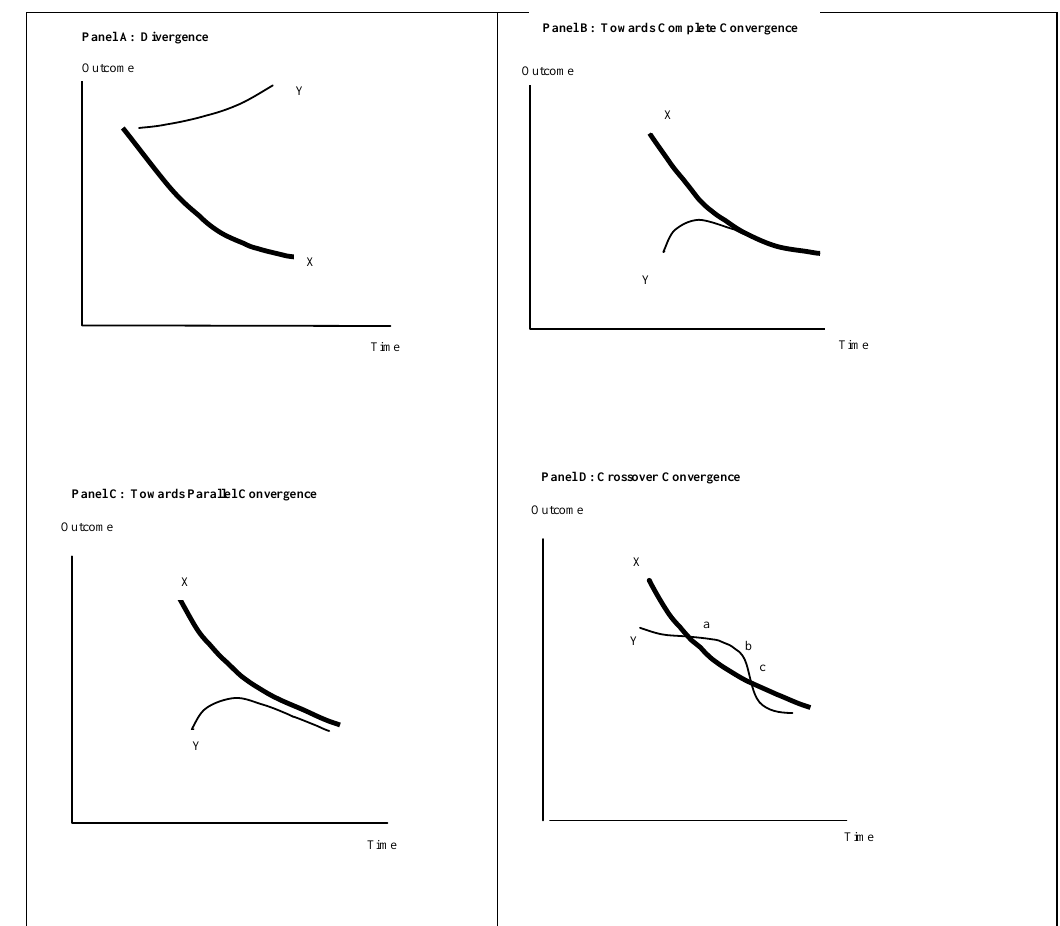
Figure 1: Visualising